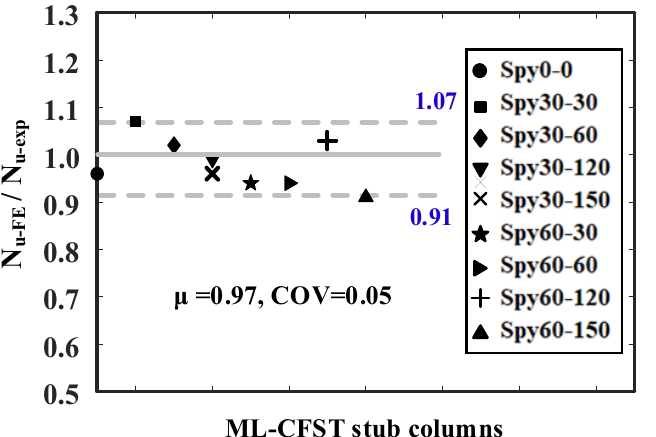
Figure 5. A comparison of the numerical results against the experimental results for the nine ML-CFST stub columns reported in [10].